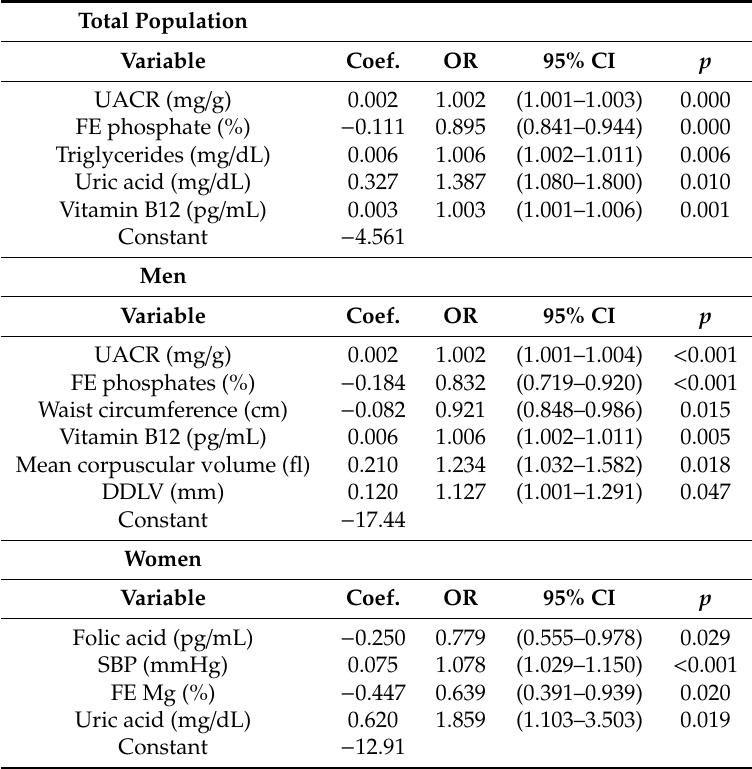
Table 3. Multivariate model for the prediction of rapid progression in the total population (men and women combined), men and